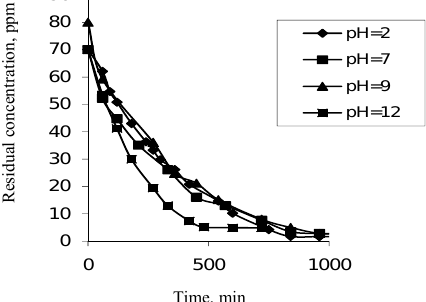
Figure 4. Residual concentration- time plots of tolonium chloride at various bufferic pH by use of optimum amount of anatase TiO (V=20 mL) 2 A plot of ln(C /C ) versus time lead to a straight line, the slope of which upon linear 0 t regression equals the observed first-order rate constant of photodegradation k Table 1).